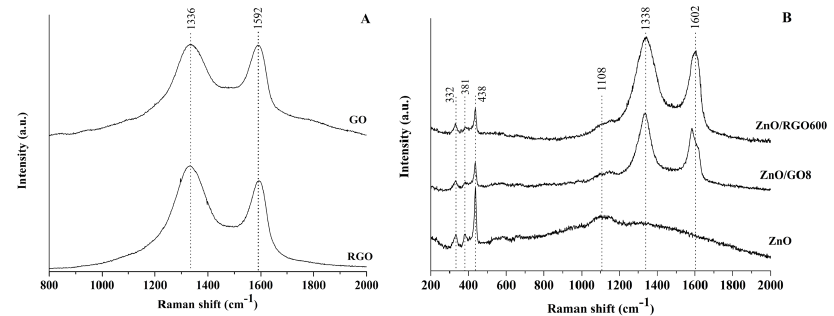
Figure 6. Raman spectra of GO and RGO (A), and ZnO, ZnO/GO8 and ZnO/RGO600